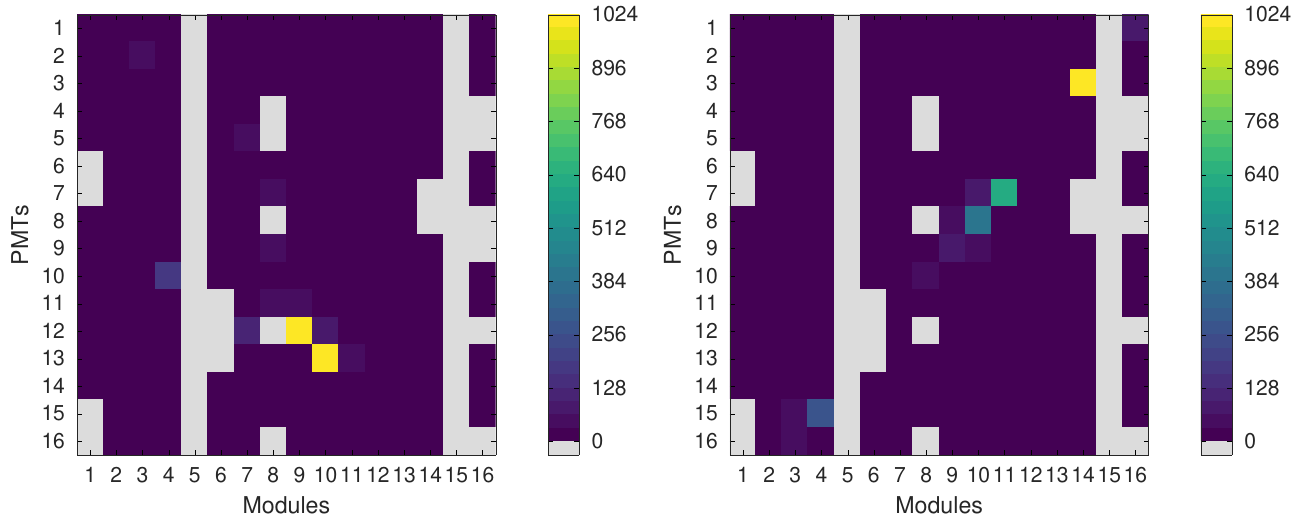
Figure 5. Examples of traces of TLFs “broken” by intersecting dead channels, see the text for details.